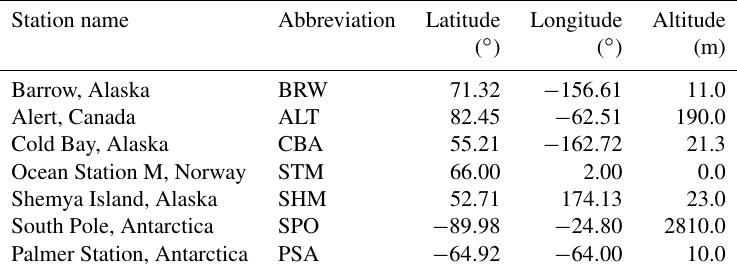
Table 1. Details of the polar station used to calculate the